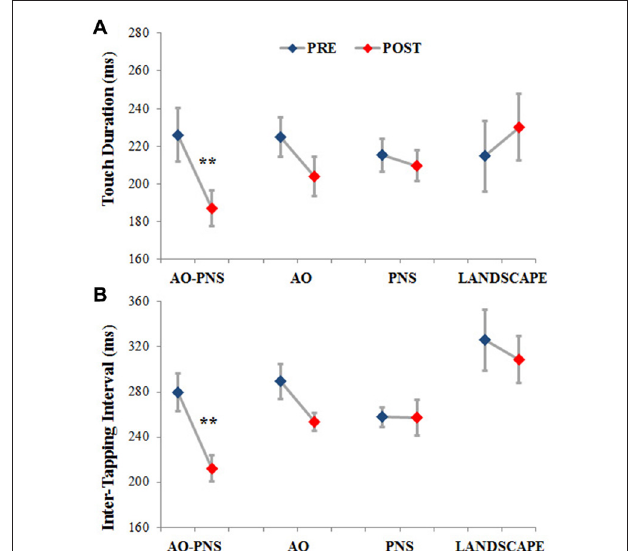
FIGURE 3 | Touch duration and inter-tapping interval. The TD (A) and the ITI (B) are represented for each experimental group before (PRE-blues) and 30 min after (POST-red) the conditioning protocol. Mean data ± standard error are shown; ** indicate significantly higher frequency in POST than PRE values ( p <